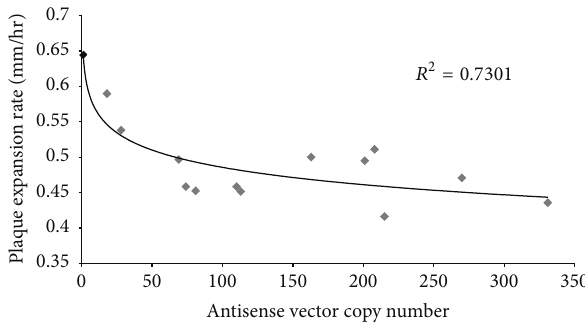
Figure 4: Plaque expansion rates of ptcB antisense transformants on Escherichia coli B2 lawns. Plaque expansion rates for ptcB antisense transformants are plotted against the copy number of the antisense construct present in each transformant, a reflection of the level of antisense inhibition. The number of copies of the antisense construct in each transformant was determined using qPCR. All transformants are shaded in grey while the wild type parental strain is in